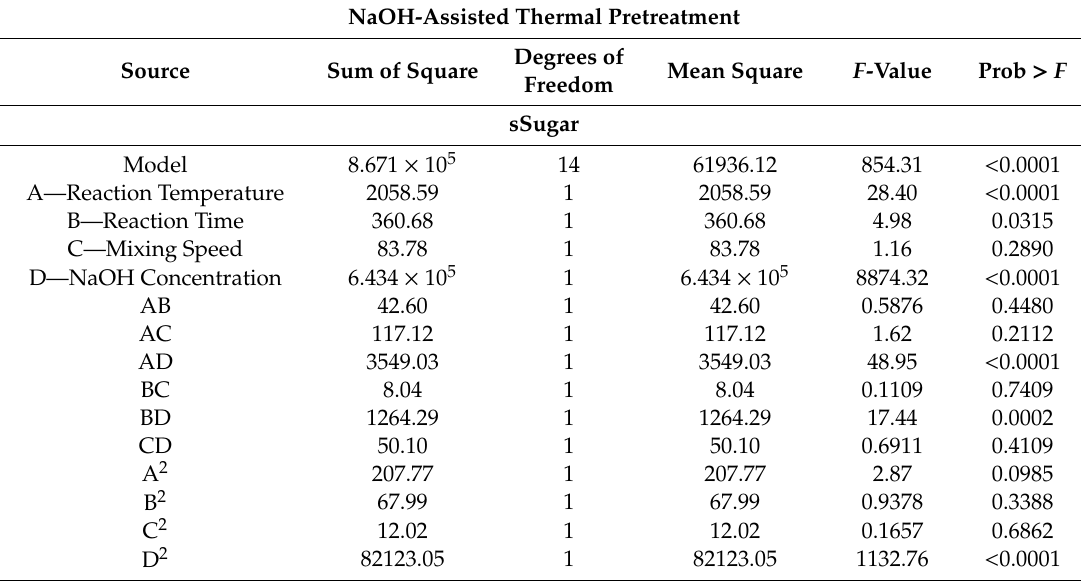
Table 4. ANOVA results for chemical-assisted thermal pretreatments for